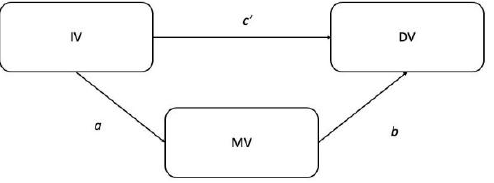
Figure 2. Model with the addition of mediation variable; c ’ = direct effect; a = effect of IV on MV; b = effect of MV on DV.